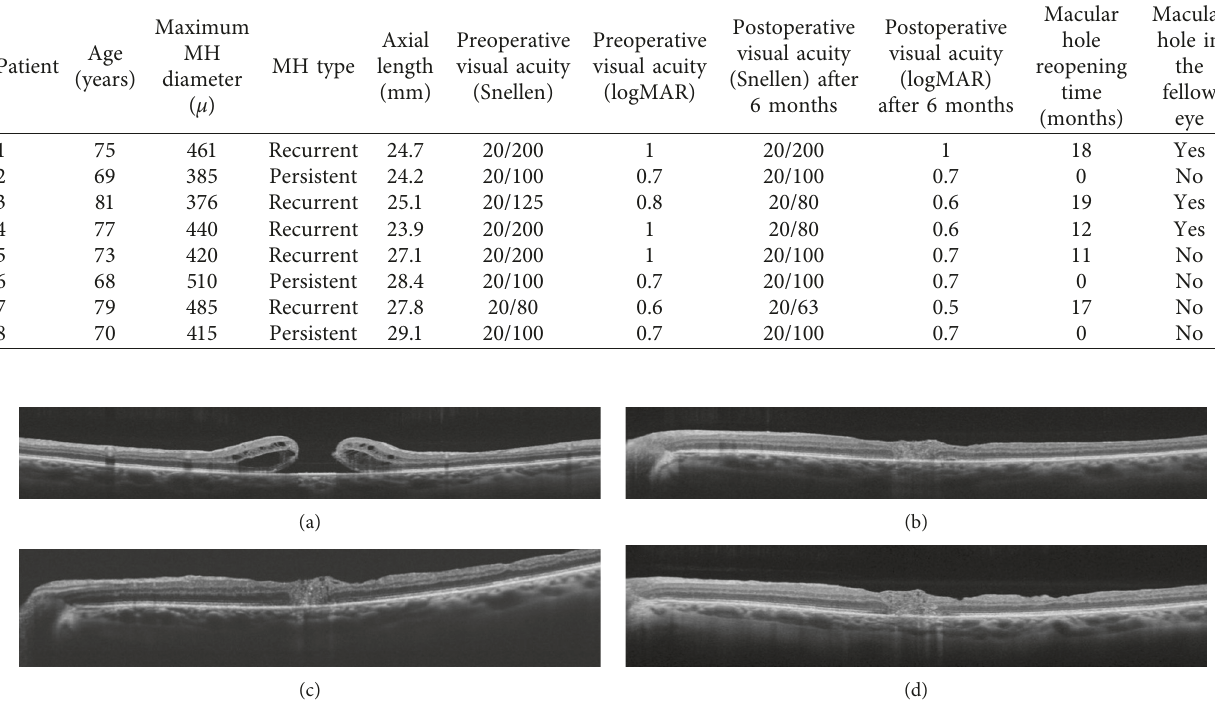
Figure 1: (a) Preoperative OCT that shows a recurrent macular hole (max. MH diameter 461). (b) 1month after the operation, the plug is positioned into the closed macular hole. (c) 4 months after the operation. (d) 6 months after the operation. We can observe a partial reconstruction of the outer retinal layers.